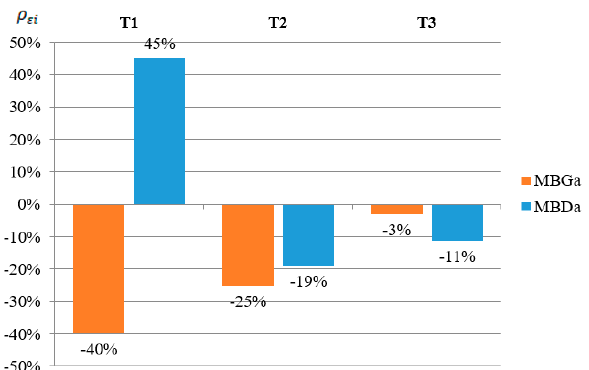
Figure 13. Strain percentage change in relation to the beams without reinforcement, read at T1, T2 and T3 at a load level of 25 kN and for different locations of the CFRP tape.